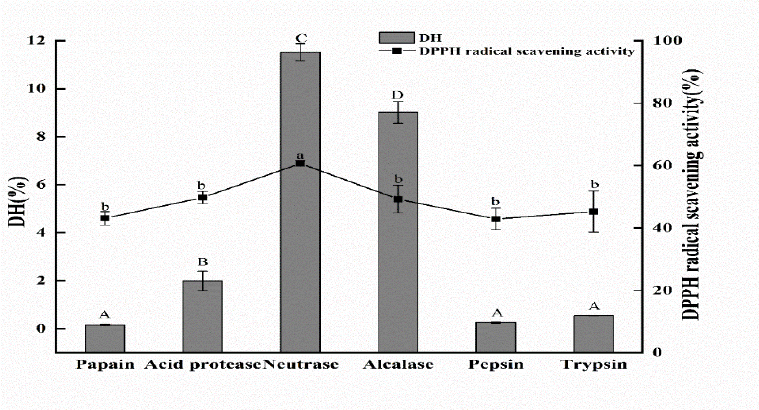
Figure 1. DH and DPPH radical scavenging activities of six protease hydrolysates. DH represented the degree of hydrolysis; DPPH radical scavenging activity assay was measured at concertation of hydrolysates was 3 mg/mL. The data indicated as means ± SD ( n = 3). The column values of a–b or A − D with the same superscript indicated an insignificant difference ( p > 0.05).